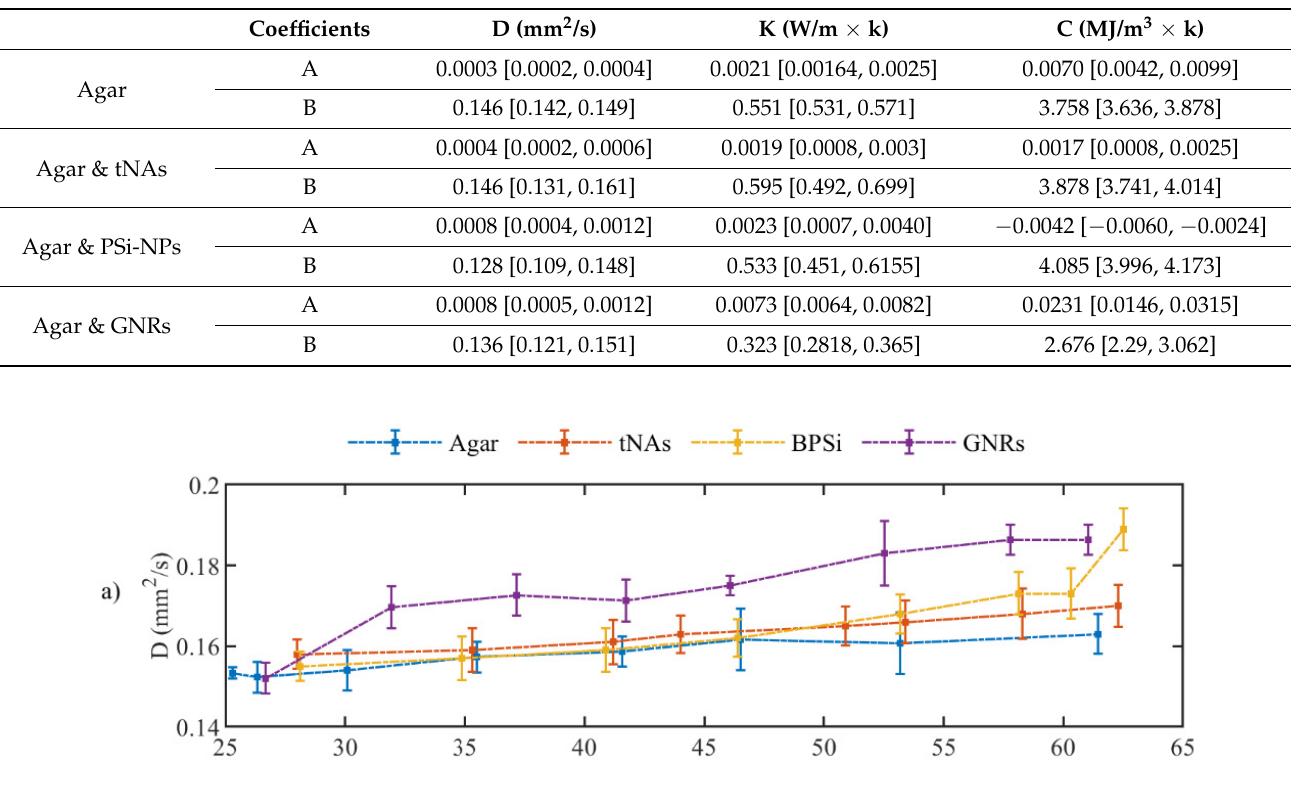
Table 1. Measured uncertainty associated to three thermal parameters with a 95% confidence level and the linear fitting coefficient of A and B. The 95% confidence bound is indicated within brackets.